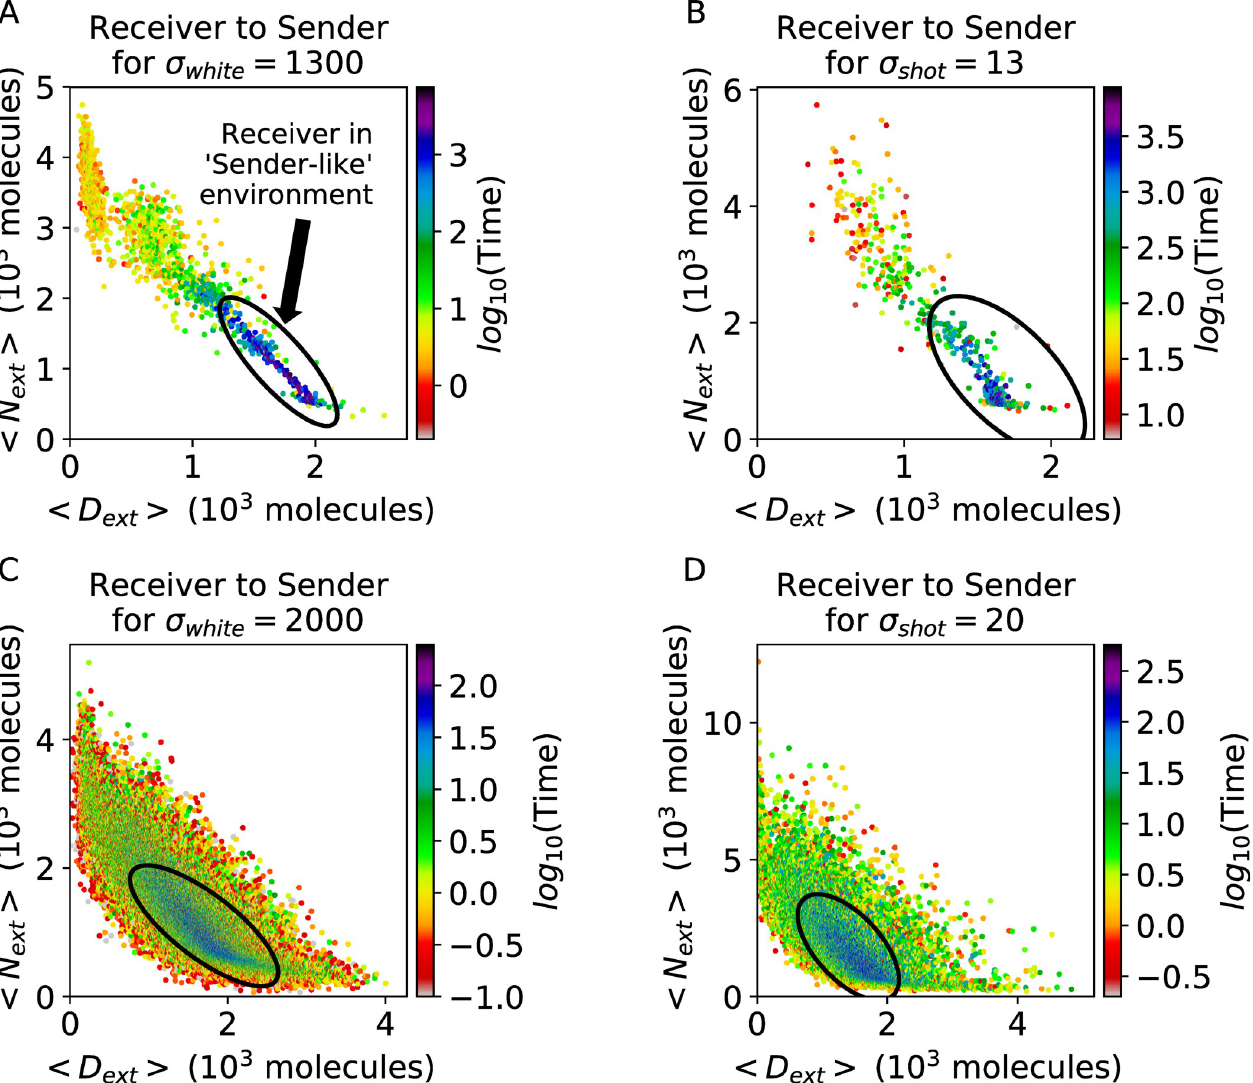
Fig 5. Timescales for single cell and lattice transitions. (a) The distribution of transition waiting times from Receiver to Sender as a function of N EXT and D EXT in a simulation starting from randomized initial conditions with white noise amplitude of σ white = 1300 for 9000 hr after a 1000 hr relaxation period. Each dot represents the average switching event, while the x- and y-coordinates represent the average levels of Delta and Notch in neighboring cells during the transition. The color scale depicts the waiting time before the transition event. The “correct” state region (a Receiver surrounded by Sender-like environment) is circled, and dots within this region exhibit the longest transition waiting time. (b) Same as (a) but for σ shot = 13. (c) Same as (a) but at a high white noise level ( σ white = 2000). These larger fluctuations also flip cells from the “correct” to “incorrect” state. (d) Same as (a) but for high shot noise ( σ shot =